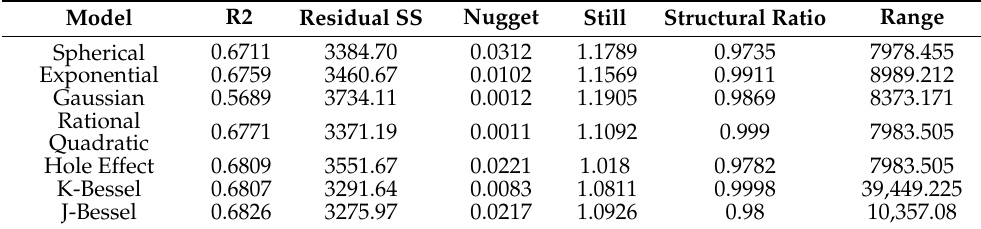
Table 4. Optimal variance function model and parameters fitted by the COK